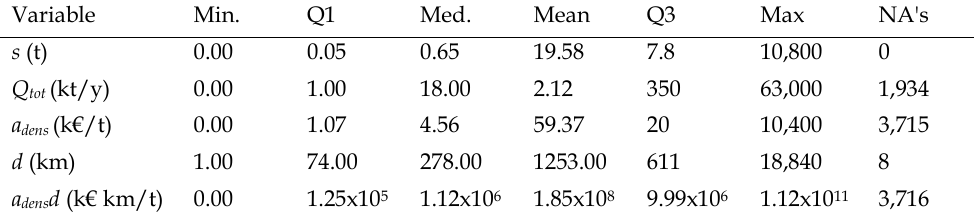
Table 2. Summary statistics of some variables of the ECHO